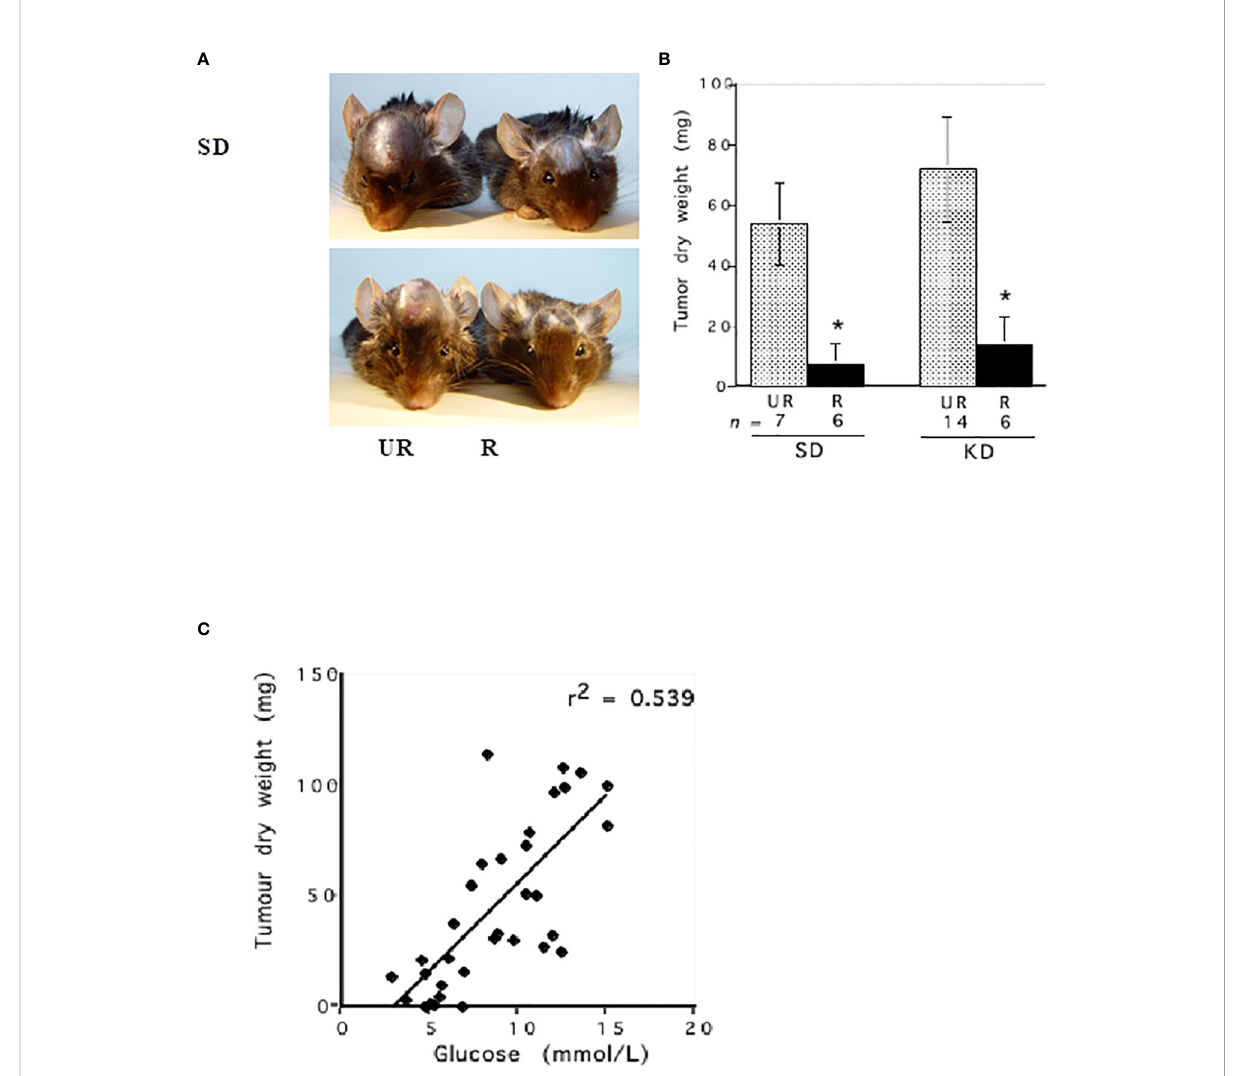
FIGURE 4 In fl uence of diet on the intracerebral growth of the CT-2A malignant astrocytoma. Dietary treatment was initiated 1 day after tumor implantation and was continued for 13 days. The visual representation (A) and quantitative assessment (B) of tumor growth in C57BL/6J mice receiving either the standard diet (SD) or ketogenic diet (KD) under either unrestricted (UR) or restricted (R) feeding. The asterisk indicates that the dry weights of the tumours in R groups were signi fi cantly lower than those in the UR groups at P < 0.01. (C) Linear regression analysis of plasma glucose and CT-2A-tumor growth in mice from both the SD and KD dietary groups combined (n = 34). These analyses included the values for plasma glucose and tumor growth of individual mice from both the UR and R-fed groups. The linear regression was highly signi fi cant at P < 0.001, indicating that blood glucose levels predict CT-2A tumor growth rate (100). The failure of the KD-UR to reduce blood glucose levels and tumor growth could be due to insulin insensitivity in this mouse strain (102). Images reproduced under a Creative Commons